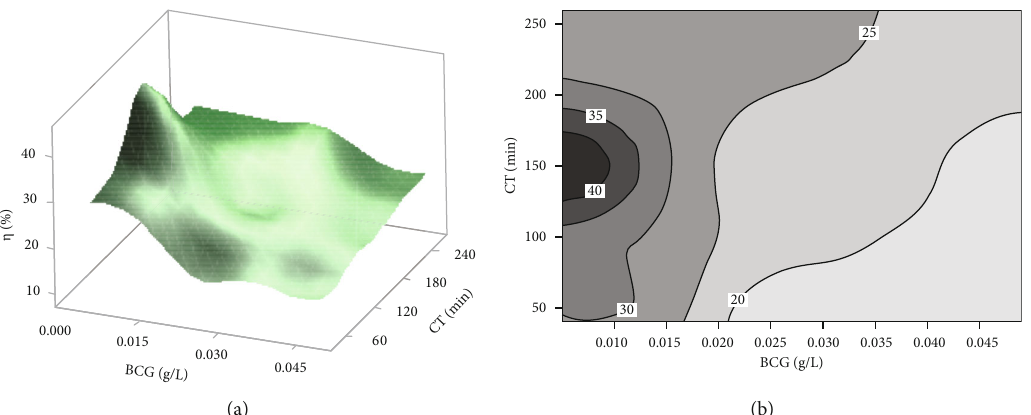
Figure 6: (a) Three-dimensional response surface displaying the e ff ects of BCG and CT on the process e ffi ciency. (b) Two-dimensional contour plot showing the e ff ects of BCG and CT on the process e ffi ciency.